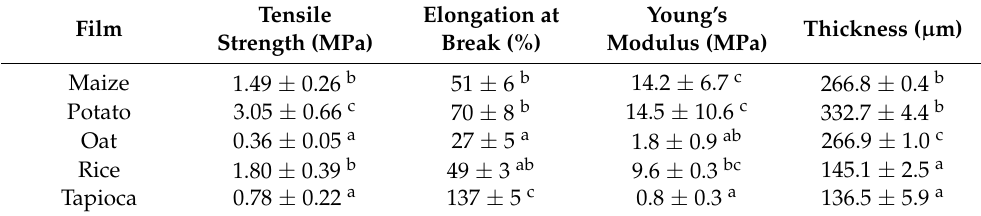
Table 3. Properties of obtained films.